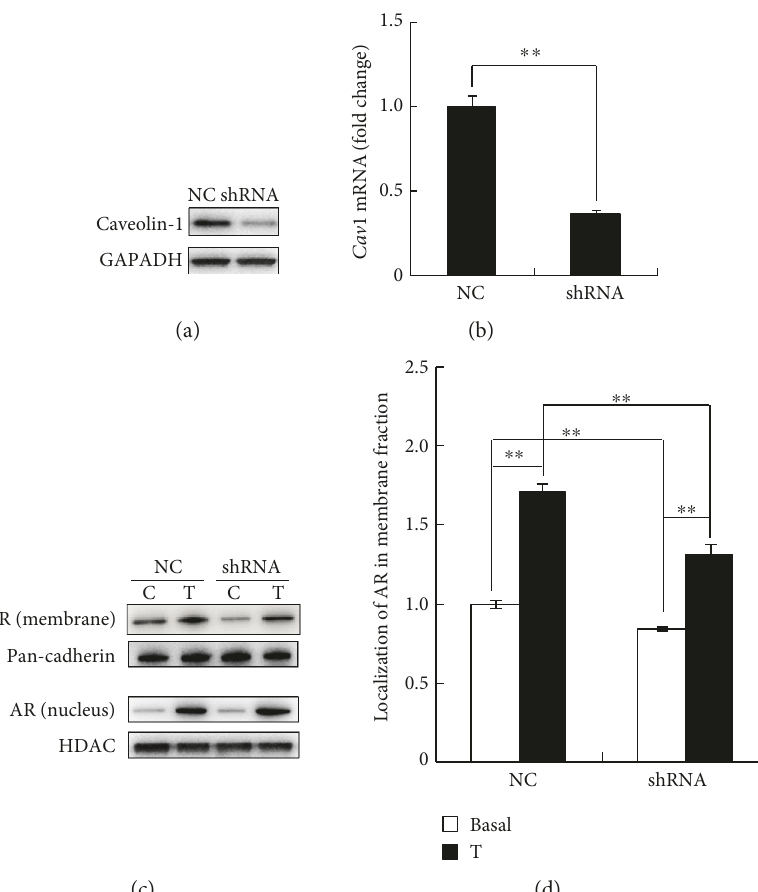
Figure 3: Knockdown of caveolin-1 decreased AR membrane localization and translocation. Results of representative Western blot analysis (a) and real-time PCR (b) show caveolin-1 knocked down by shRNA transfection. (c) Representative Western blot analysis indicating that AR tra ffi cking under 10nM testosterone treatment in membrane and nuclear fractions from cells transfected with negative control shRNA or caveolin-1 shRNA. (d) The graph shows the mean and SEM of AR expression in the membrane fraction from 4 experiments. Values are expressed as fold-change of the negative control basal. ∗∗ P < 0 01